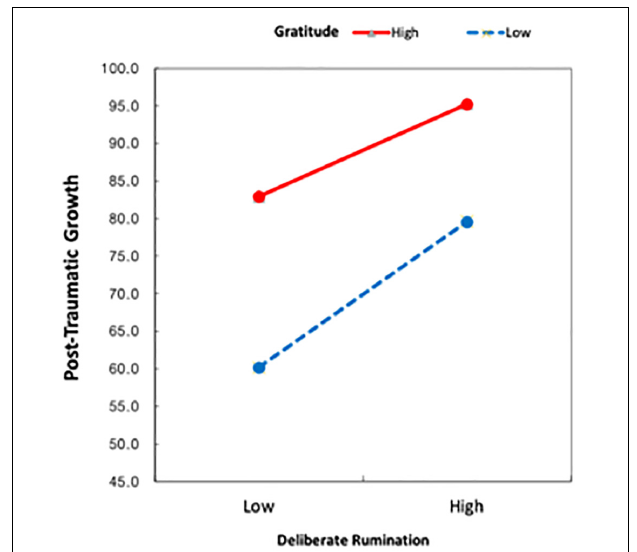
FIGURE 2 | Gratitude moderated the relationship between deliberated rumination and post-traumatic